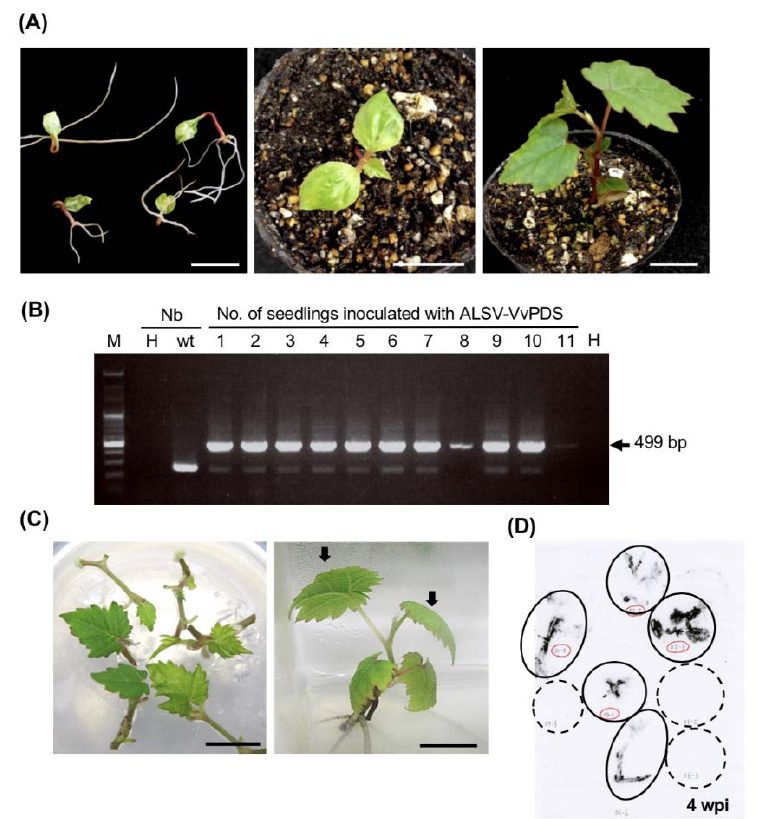
Figure 2. Inoculation of grapevine seedlings and in vitro cultures with ALSV. ( A ) Three growth stages of grapevine seedlings (‘Koshu’) used for ALSV vector inoculation. Left: ‘Folded cotyledons’, center: ’Expanded cotyledons’, and right: ‘Three true leaves’ stages. ( B ) RT-PCR detection of ALSV-VvPDS in grapevine seedlings inoculated at the ‘folded cotyledons’ stage. The third true leaves were assayed. Nb, N. benthamiana ; H, non-inoculated healthy plant; wt; wtALSV-infected plant. ( C ) Three true leaf stages of in vitro cultures (‘Neo Muscat’) used for ALSV vector inoculation in non-rooted ( left ) and rooted ( right ) cultures. ( D ) Tissue blot hybridization of cultures inoculated with wtALSV in the non-rooted culture by PDS-1000 / He ™ system. Circles and dotted circles indicate infected and uninfected plantlets, respectively.